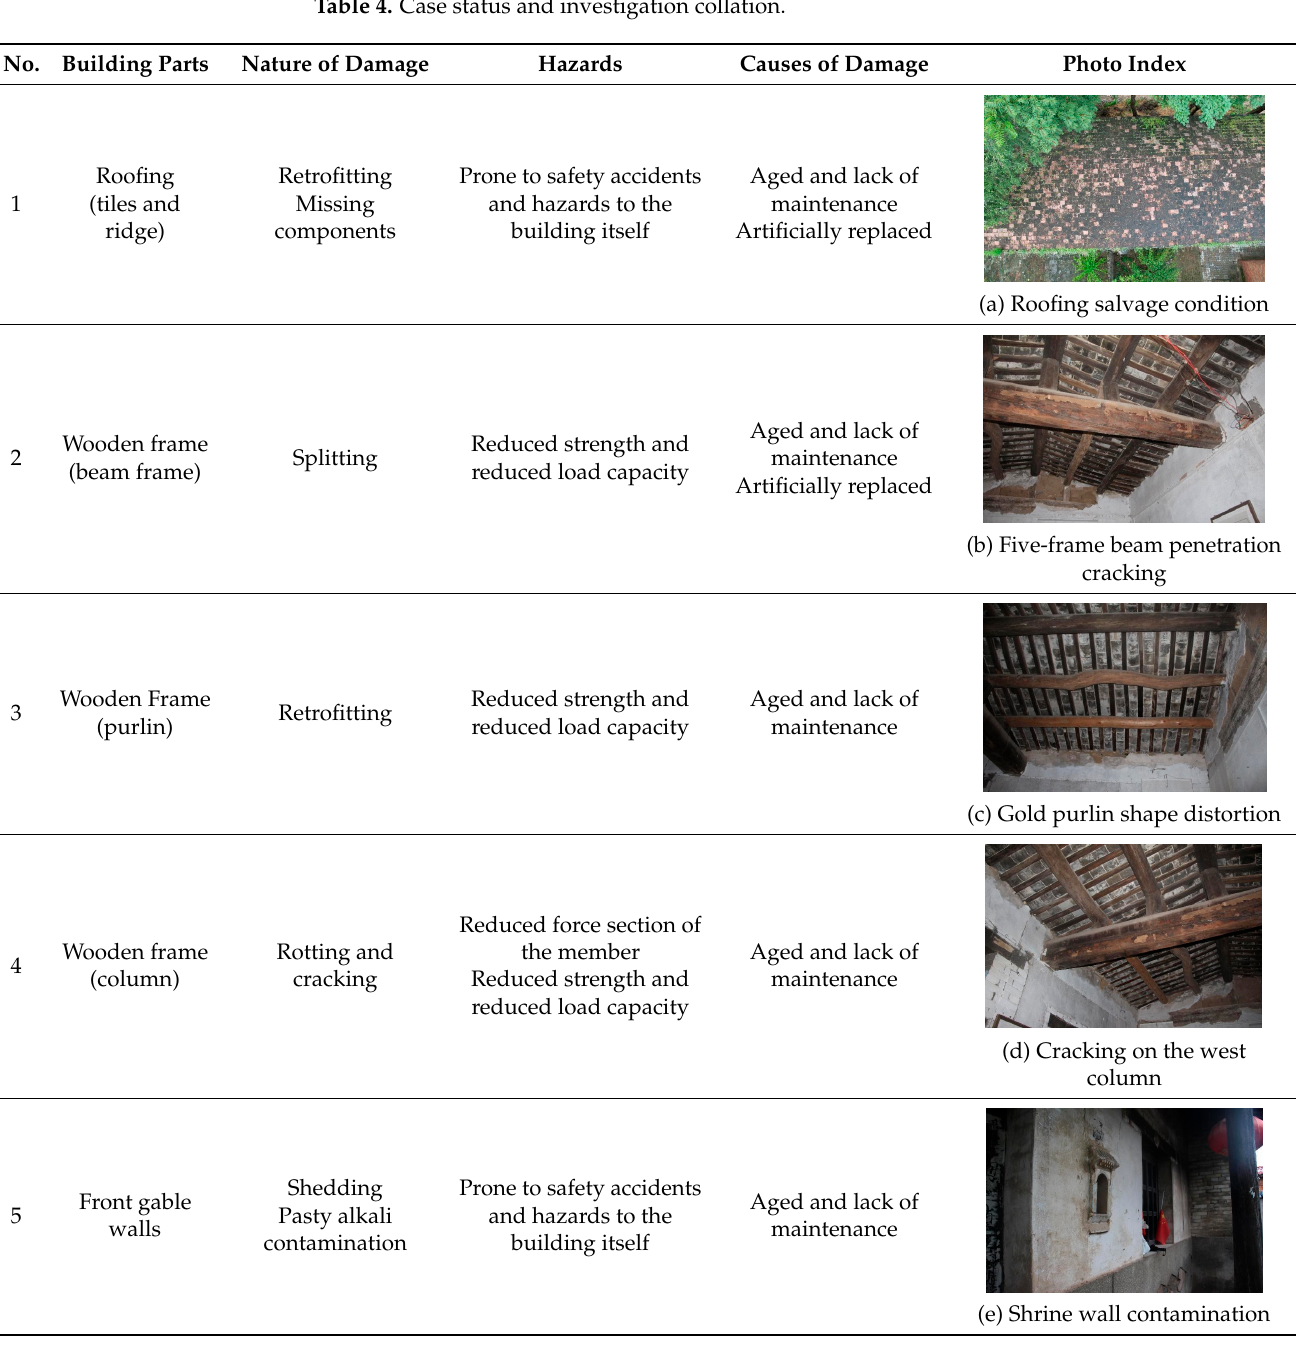
Table 4. Case status and investigation collation.